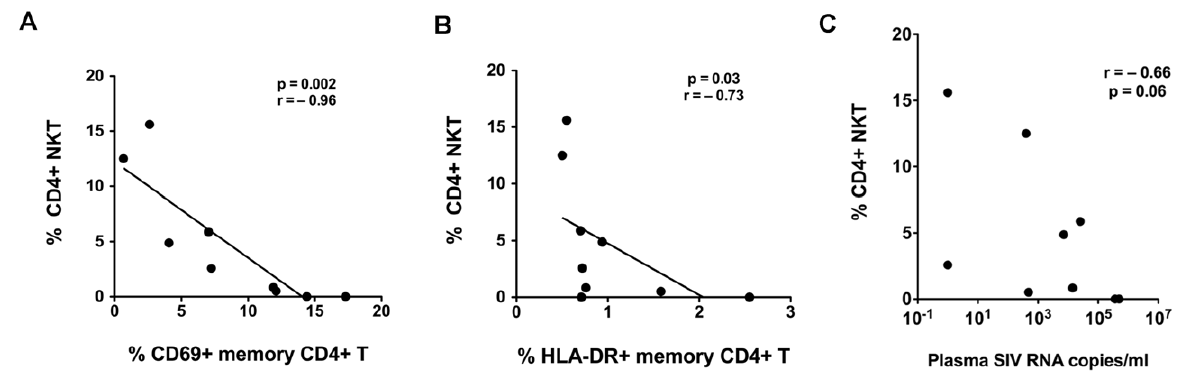
Figure 8. Relationship between CD4 + NKT lymphocyte decline and T cell activation and SIV viral loads in SIV-infected cynomolgus macaques. Correlation between proportion of CD4 + NKT lymphocytes and expression of the activation markers (A) CD69 or (B) HLA-DR on peripheral blood memory CD4 + T lymphocytes (CD4 + CD95 + T cells). C) Correlation between plasma SIV RNA and frequency of CD4 + NKT lymphocytes. P -values shown for Spearman rank correlation test. Data in 9 SIV-infected CM